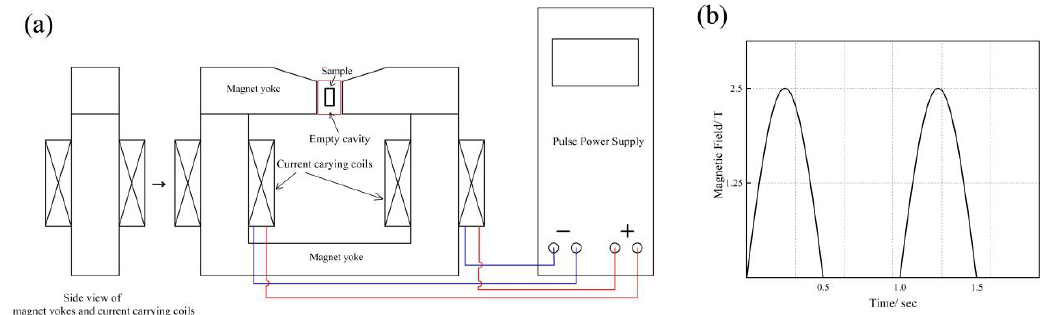
Figure 1. ( a ) Schematic of the pulsed magnetic field equipment; ( b ) half sine-wave pulsed magnetic field during the treatment.